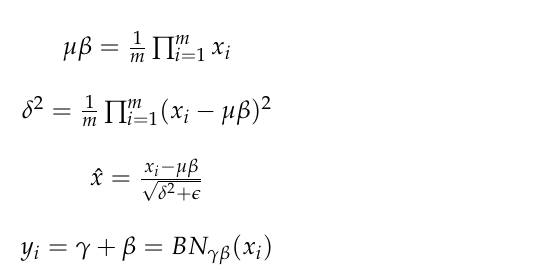
Figure 8. Comparison of the accuracy of classification of respiratory states with batch